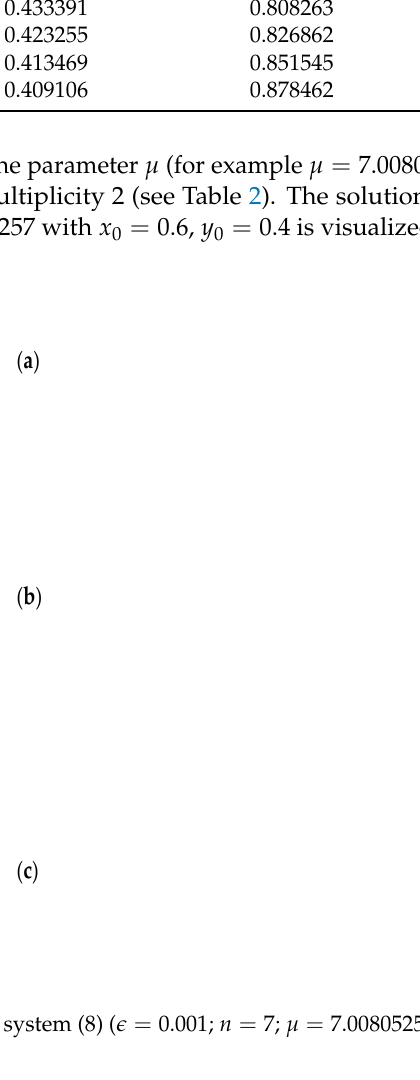
Table 2. The values of µ that proceed in 3 positive zeros of the Melnikov polynomial (Theorem 2); for µ = 7.00487909525: a simple limit cycle and limit cycle with multiplicity–2. µ